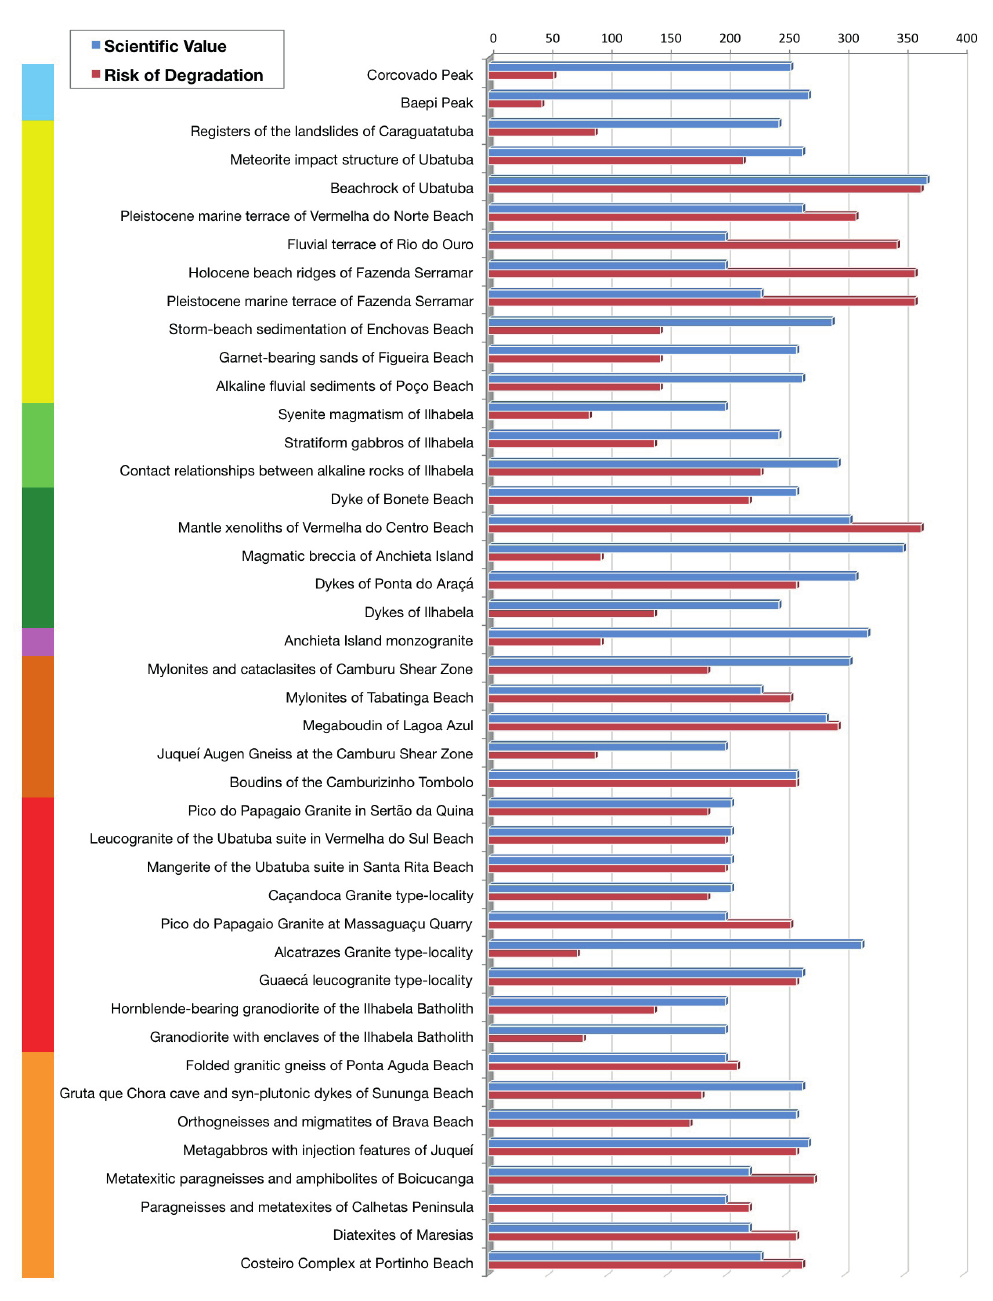
Figure 8 - Quantitative assessment related to the Scientific Value and Degradation Risk. Dashed lines correspond to key values for both criteria. According to GEOSSIT, sites with scientific value above 200 are considered geosites (200 and 300 - national relevance; > 300 - international relevance). Below 200, it would be named a geodiversity site. According to Brilha (2016), degradation risk values can be classified as low (< 200), moderate (200-300) and high